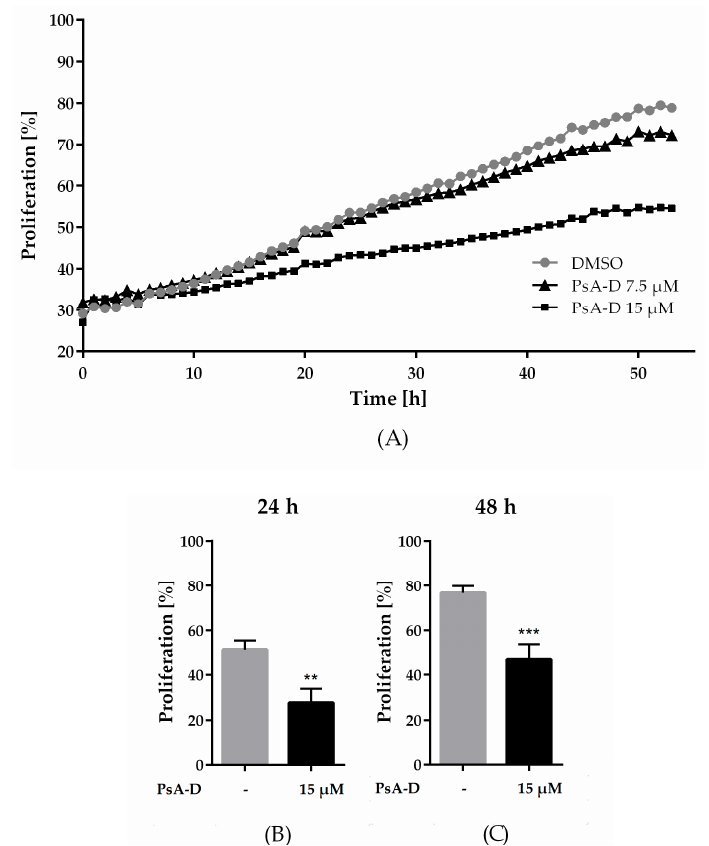
Figure 1. Pseudopterosin inhibited proliferation in triple-negative breast cancer cells. ( A ) Proliferating cells were imaged every hour over a time range of 50 h with the IncuCyte ® ZOOM. Confluency of cells was determined with IncuCyte ® software indicated as proliferation in percentage. Cells were treated with either 7.5 µM (triangle) or 15 µM (square) of pseudopterosin extract (PsA-D). ( B , C ) Inhibition of proliferation is shown at selected time points of 24 and 48 h compared to DMSO control, respectively. The data represent means of three independent experiments. Error bars were calculated using ±SEM. p -values were calculated against DMSO control. Two stars represent a significance of p < 0.01 and three stars represent a significance of p < 0.001.